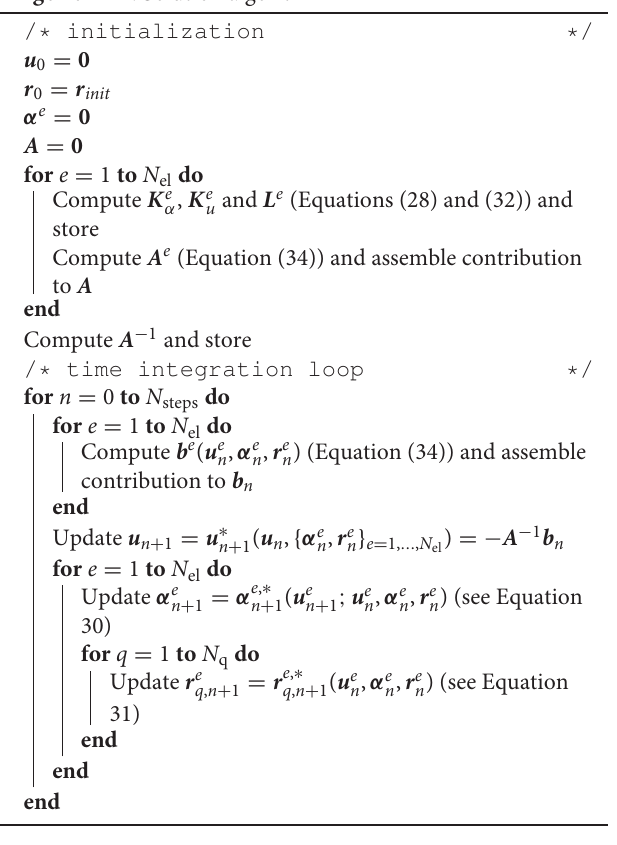
TABLE 1 | Element DOFs and quadrature rules employed in numerical integration of residuals and tangents. Element DOFs Quadrature rule